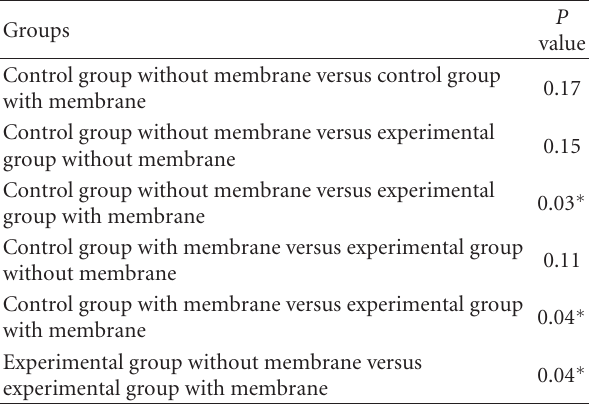
Table 1: Statistical comparisons between groups were significant. P values < 0.05 were marked ( ∗ ).